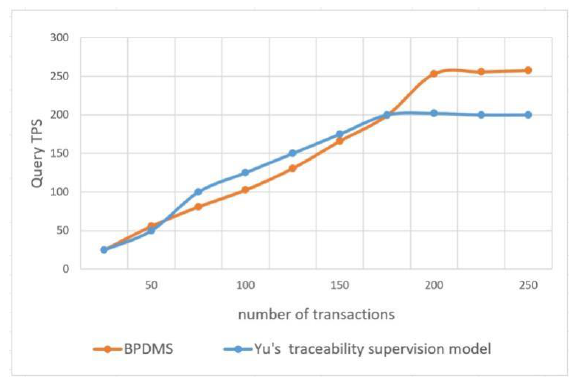
Figure 12. The throughput rate of query data.